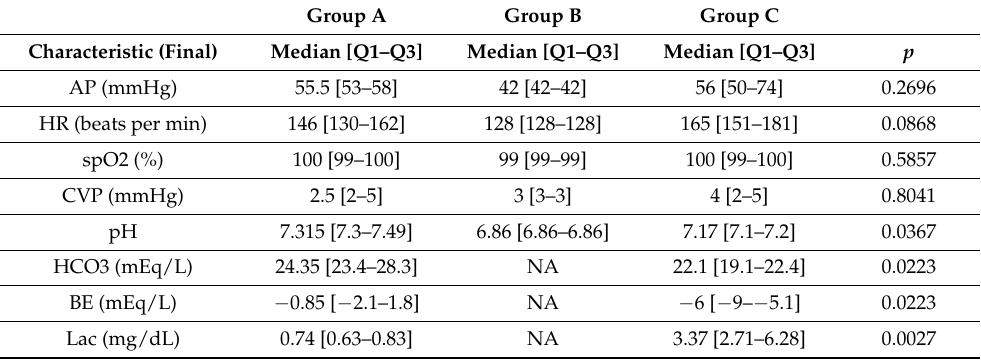
Table 5. Animal characteristics at the final stage. NA: not applicable. Venous and arterial blood samples and hemodynamic parameters. AP = Arterial Pressure, HR = Heart Rate, spO 2 = Oxygen saturation, CVP = Central venous pressure, pH = potential of hydrogen, HCO 3 = Bicarbonate, BE = Base Excess, Lac = Lactate. Group